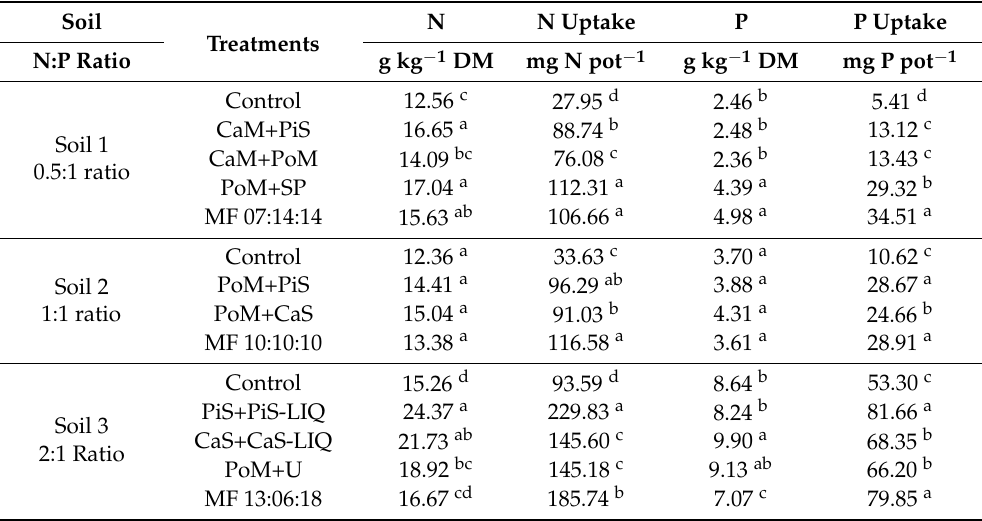
Table 4. Nitrogen and phosphorus, concentrations in the plant material as well as nutrient uptake calculated based onplant yield and nutrients concentrations in the plant. Results for each ratio in each column followed by different letters differ significantly for p < 0.05 (Tukey